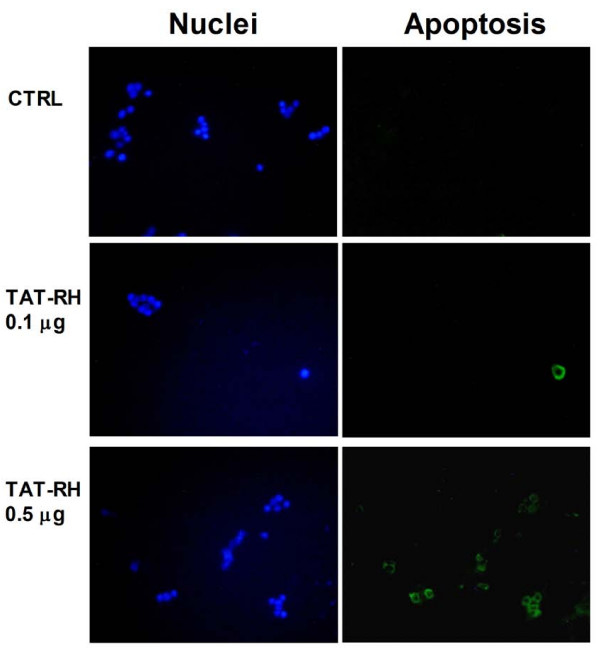
Apoptosis analysis by Annexin V staining in TAT-RH treated cells. To verify the effect of TAT-RH on NFκB-dependent apoptosis, we performed an Annexin V staining analysis in KAT-4 cells using different doses of TAT-RH to verify the minimum amount of protein needed to exert biological functions (green = Annexin V; blue = nuclei).